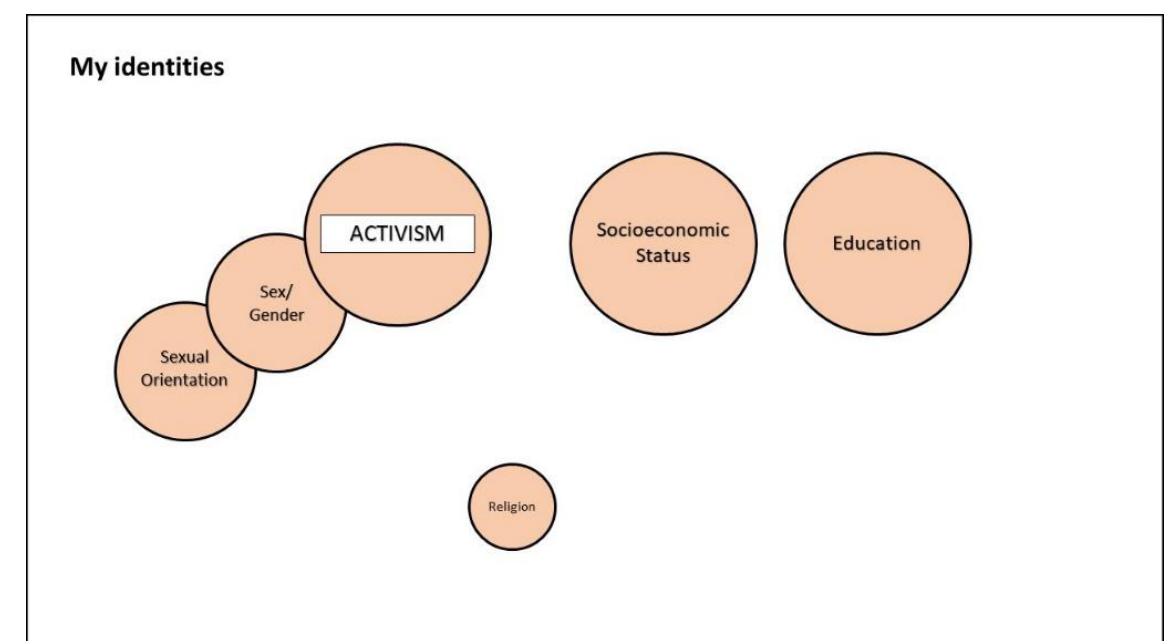
Figure 1. Example of the identity mapping of one participant, referring to the post-migration period.